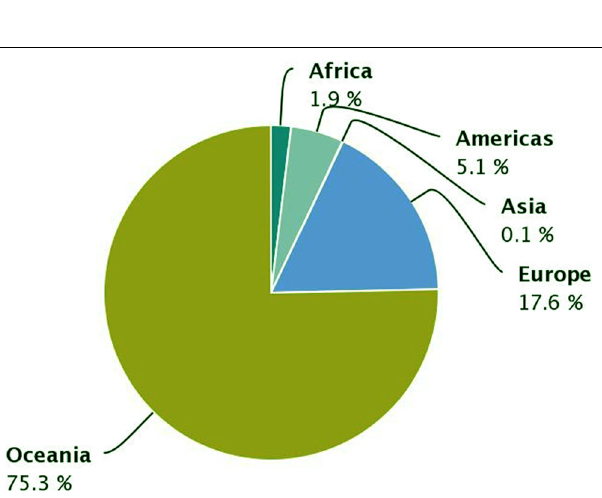
FIGURE 2 | Worldwide distribution of lupin production. Source: FAOSTAT